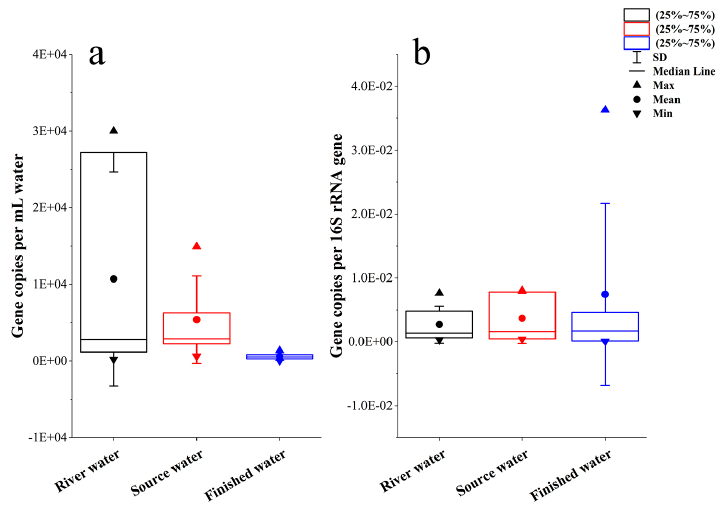
Figure 3. Total absolute ( a ) and relative ( b ) abundances of ARGs (copies/mL water) in river, source, and finished water. Table 1. The log removal of ARGs in the treatment processes of six sample cities.